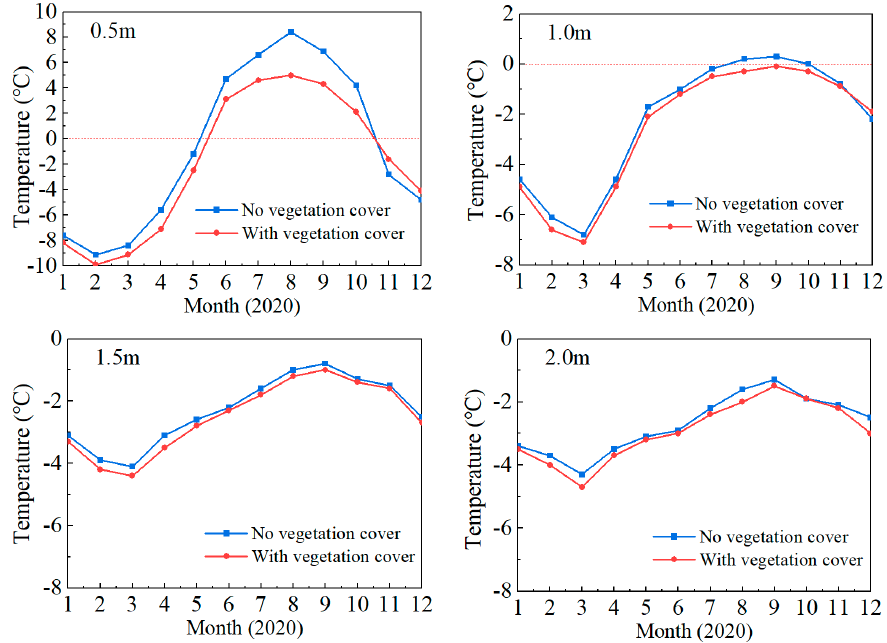
Figure 7. Variation of monthly average underground temperature at the same depth of borehole T1 (with vegetation cover) and borehole T2 (no vegetation cover) in 2020.